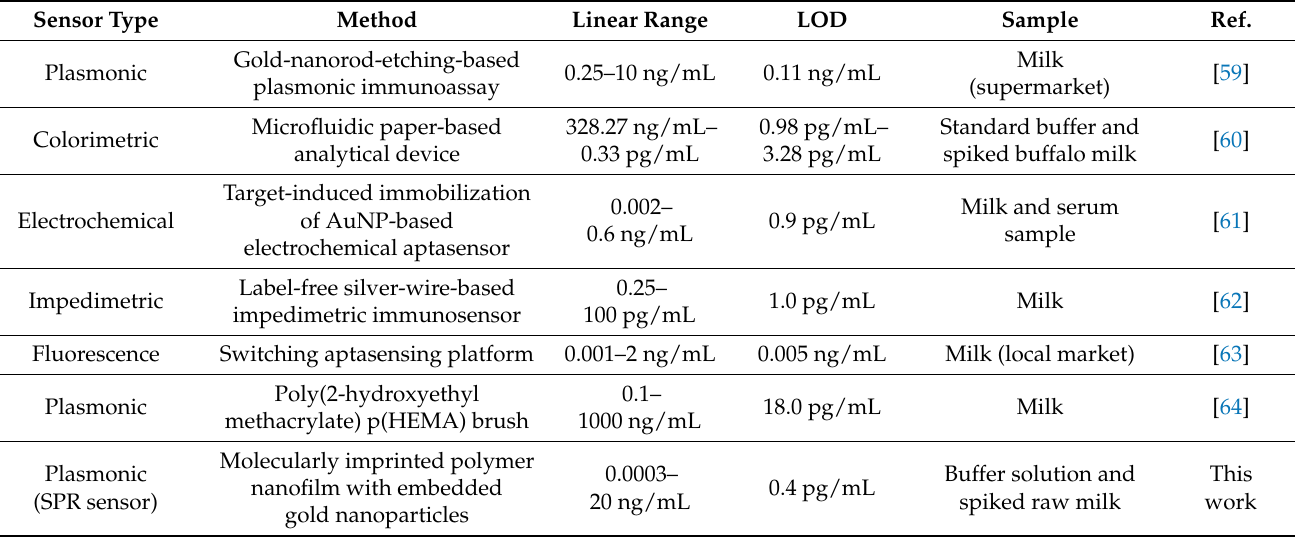
Table 1. Comparison of different sensing platforms for the detection of Aflatoxin M1 in milk samples.